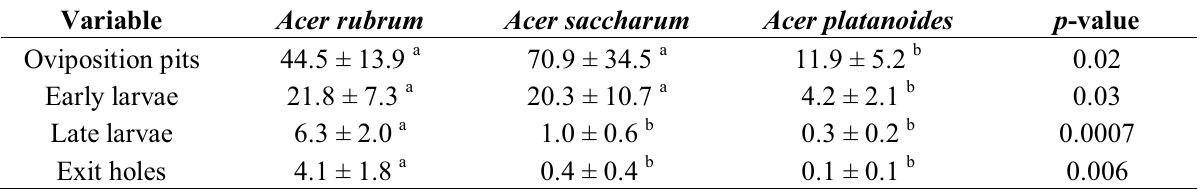
Table 2. Mean (±SE) estimates of life stages and signs of Asian longhorned beetle per tree in three Acer species from the Delaval stand. Means followed by the same superscript letter within a row are not significantly different (Tukeys HSD, p >